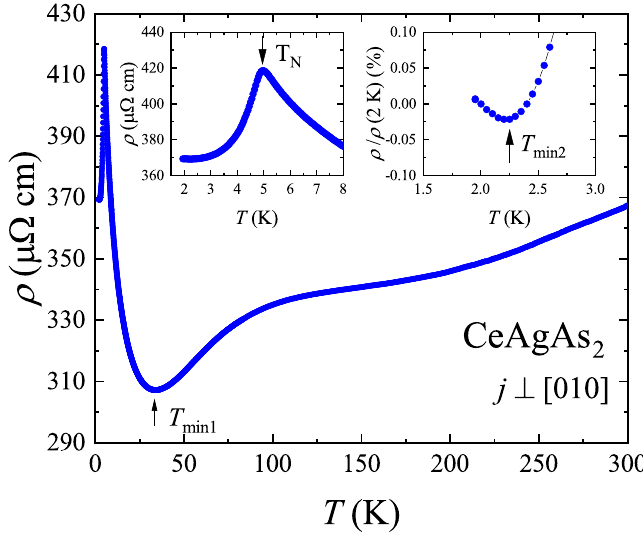
Figure 6. Electrical resistivity ρ ( T ) of single-crystalline CeAgAs 2 measured within the crystallographic (010) plane. The insets present the low-temperature data highlighting the maximum of the resistivity at T N (left-hand side) and the minimum at T min2 (right-hand